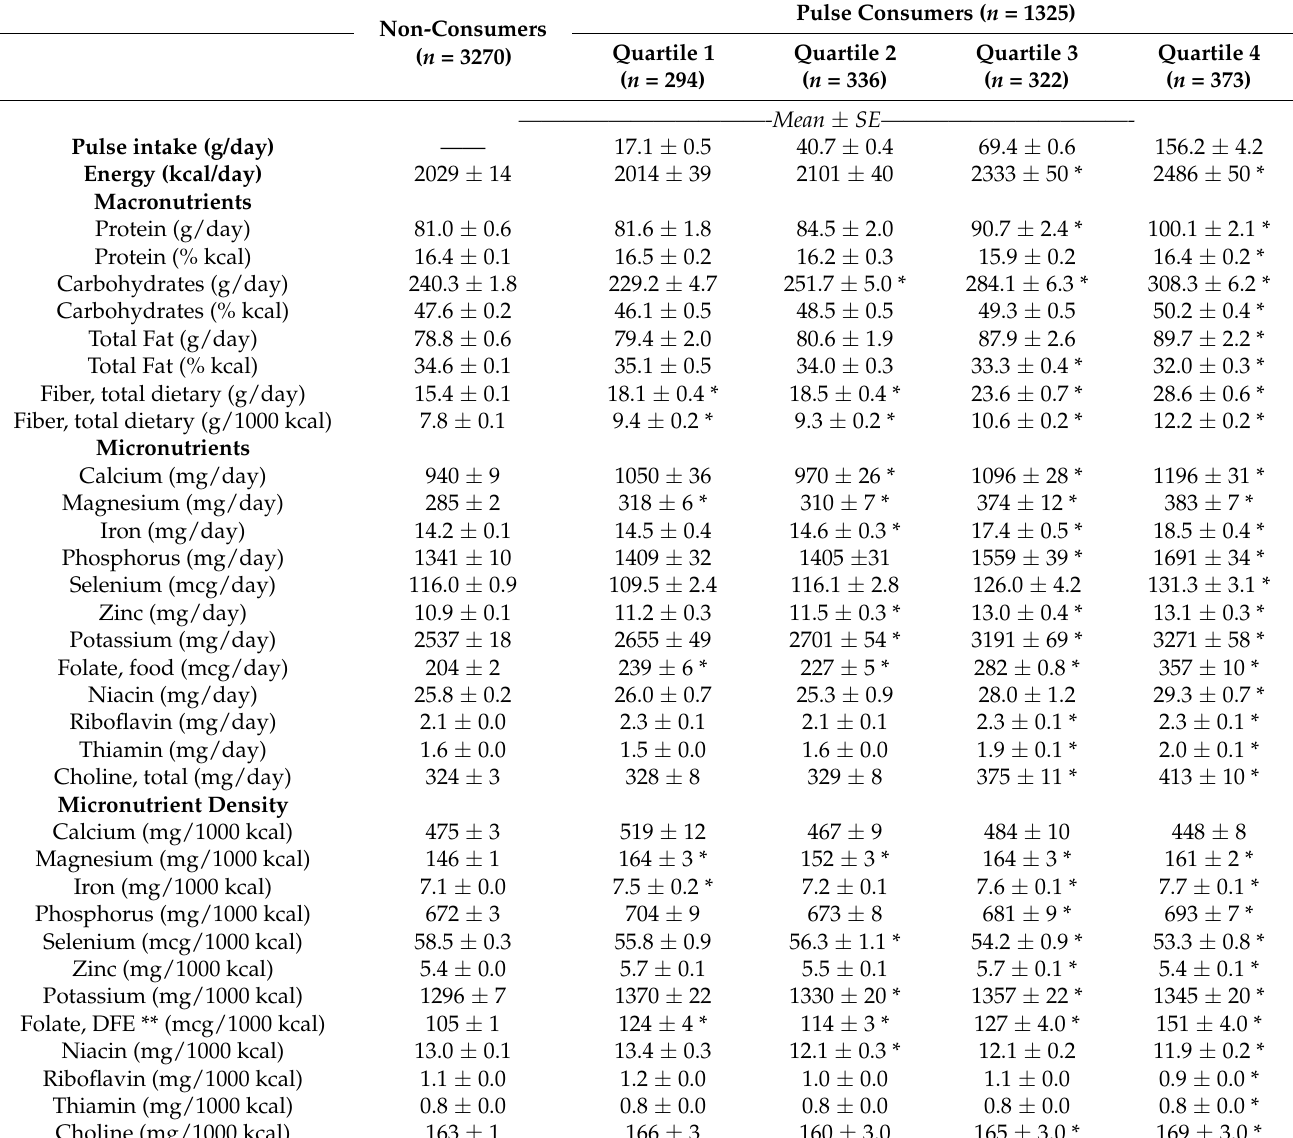
Table 2. Pulse amount, energy and nutrient intake for non-consumers and by quartile of pulse consumers based on 2-day dietary intakes from the National Health and Nutrition Examination Survey (NHANES),